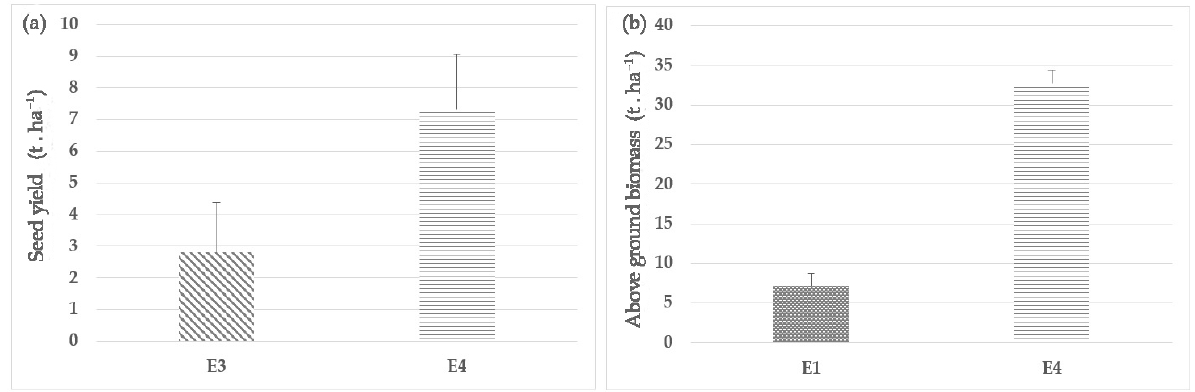
Figure 1. Seed yield ( a ) and above ground biomass ( b ) of most contrasting environment. E1, E3, and E4 represent the different environments (see Table 2 for more details). Values (means ± SE, n = 3).